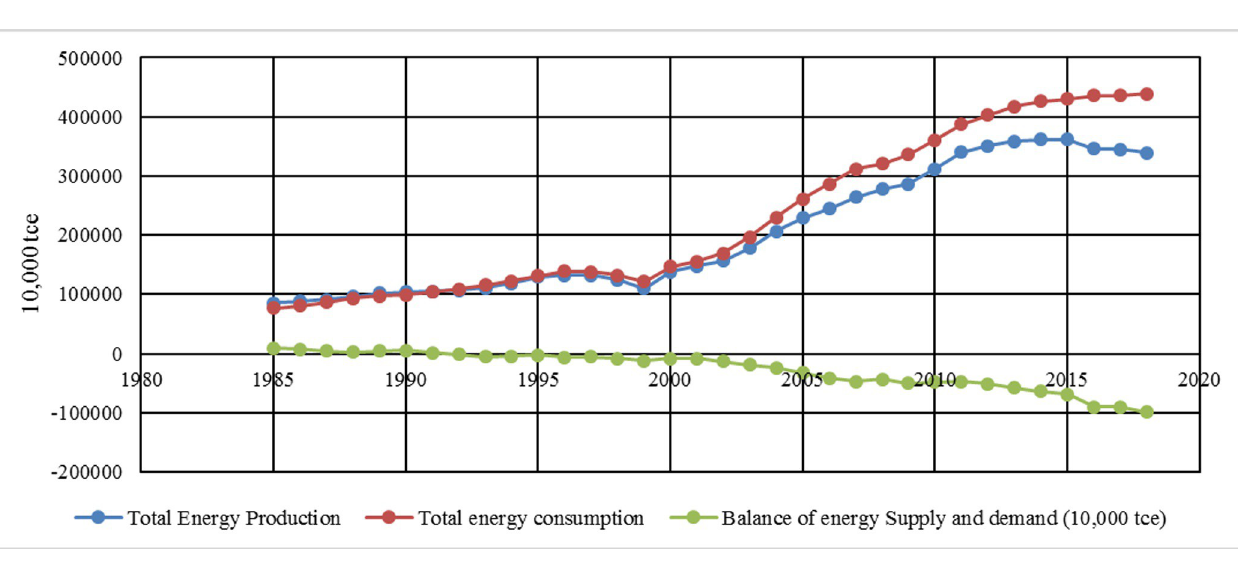
Fig 4. Changes in China’s energy supply and demand from 1985 to